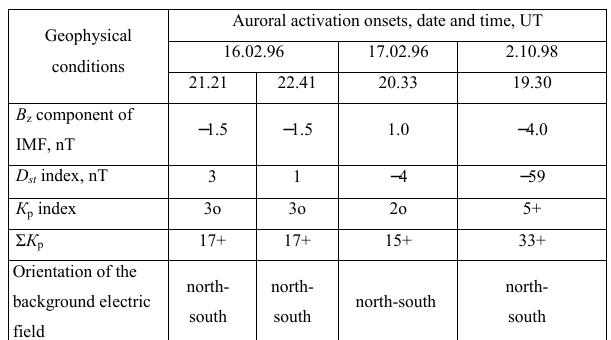
Table 3. Background geophysical conditions in course of the HF pumping experiments